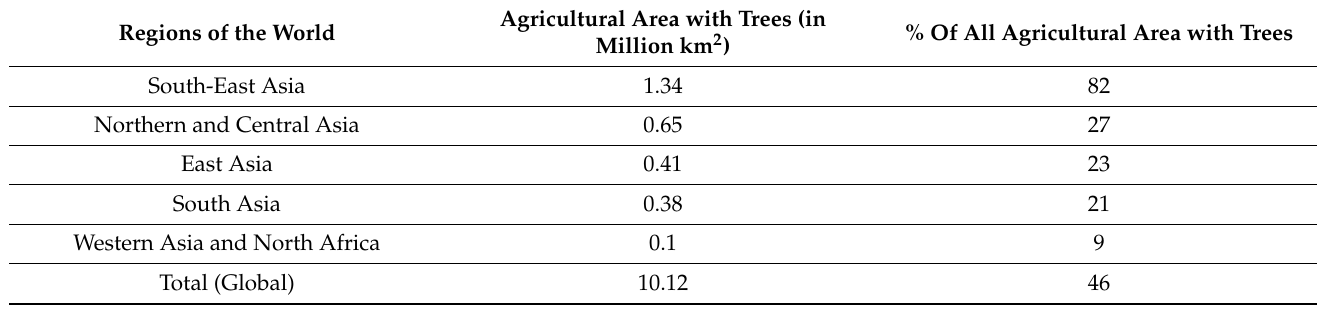
Table 3. Extent of agroforestry systems in different parts of